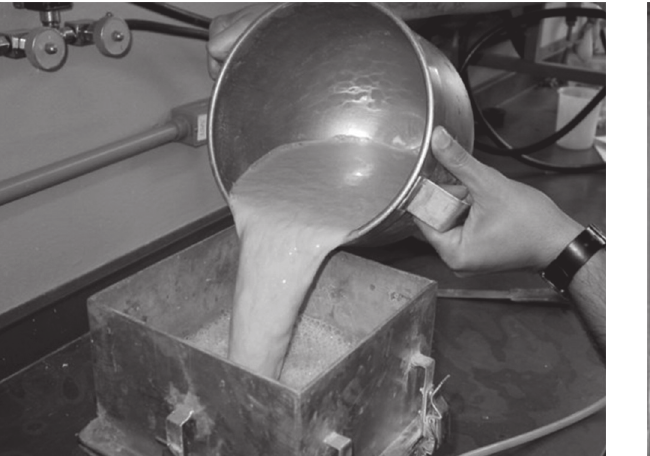
Figure 5. Cutting of the plates. Figure 3. Mold.